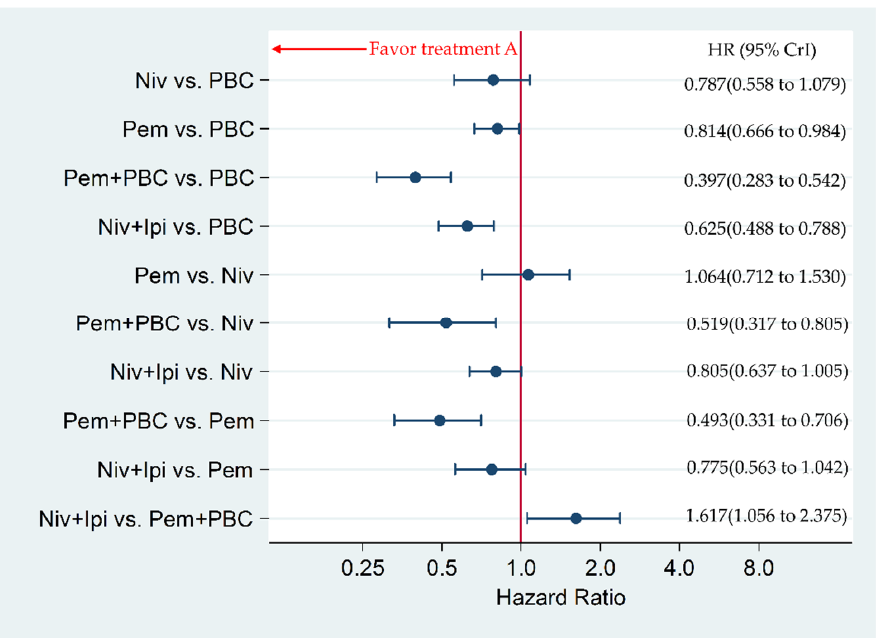
Figure 4. Comparative efficacy for progression-free survival (PFS) among the five therapeutic regimens (Niv+Ipi, Pem+PBC, Pem, Niv, and PBC) in patients with programmed cell death ligand 1 (PD-L1) expression levels of 50% or more. Comparisons were expressed as Treatment A versus Treatment B. Data are expressed in terms of hazard ratio (HR) and 95% credible intervals (CrIs); Niv, nivolumab; PBC, platinum-based chemotherapy; Pem, pembrolizumab; Ipi, ipilimumab.